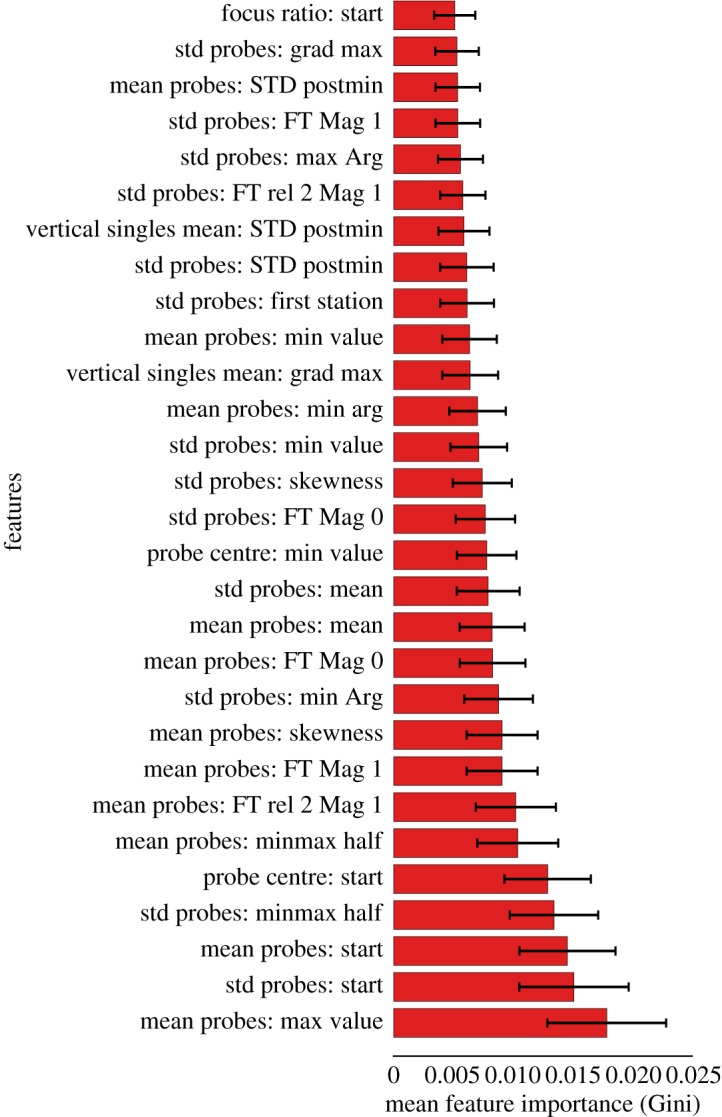
Figure showing the top 29 features by importance of an example random forest model using the Gini index. The prefix refers to a particular gradient/measure across the electrode grid. The suffix refers to a single electrode feature.The feature ‘start’ can be manipulated to calculate the wavefront direction. As the random forest model is trained, the reduction of the Gini index caused from each feature is measured and averaged across the whole decision tree ensemble. From this particular random forest, the mean maximum voltage and standard deviation of the start index are important features. It can also be seen that from the magnitude of the Gini values, no individual feature is suitable just by itself. These plots help determine suitable feature sets for future models.